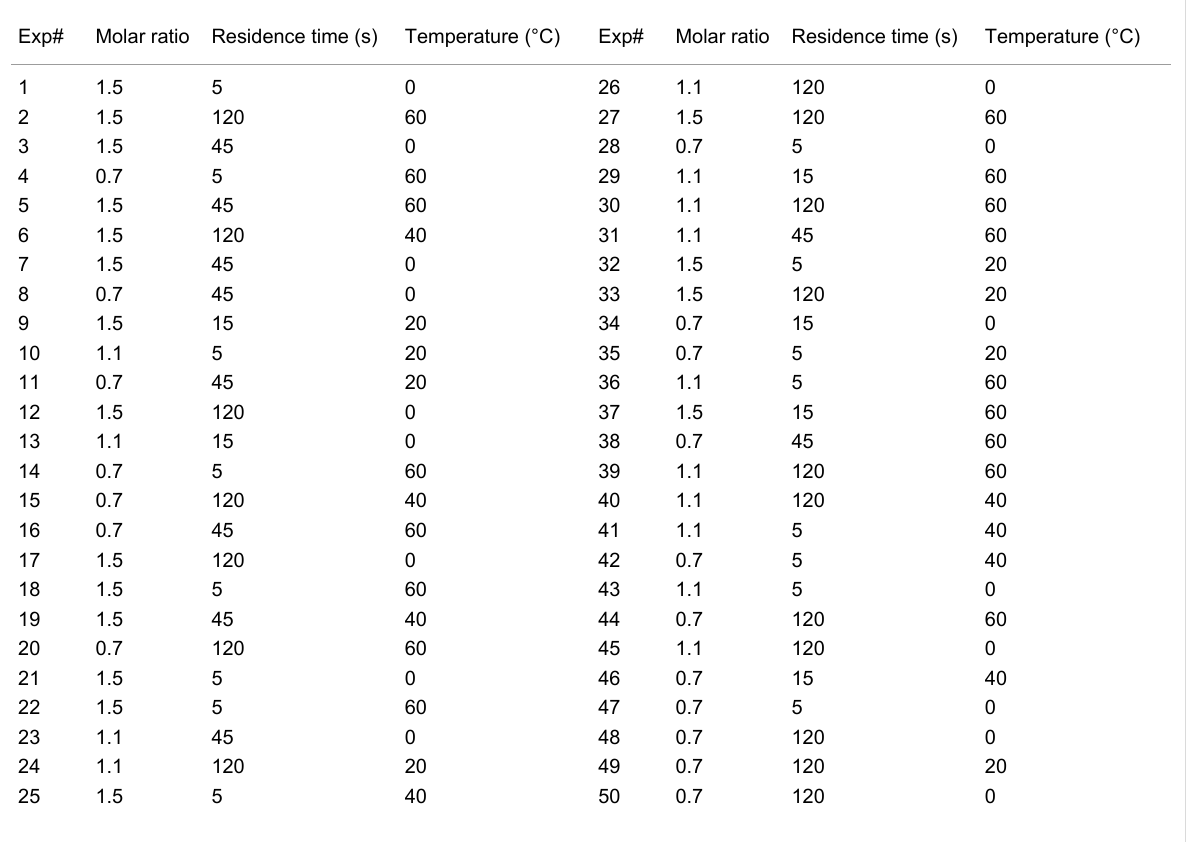
Table 2: Experiments for the multivariate optimization deduced from a D-optimal experimental design